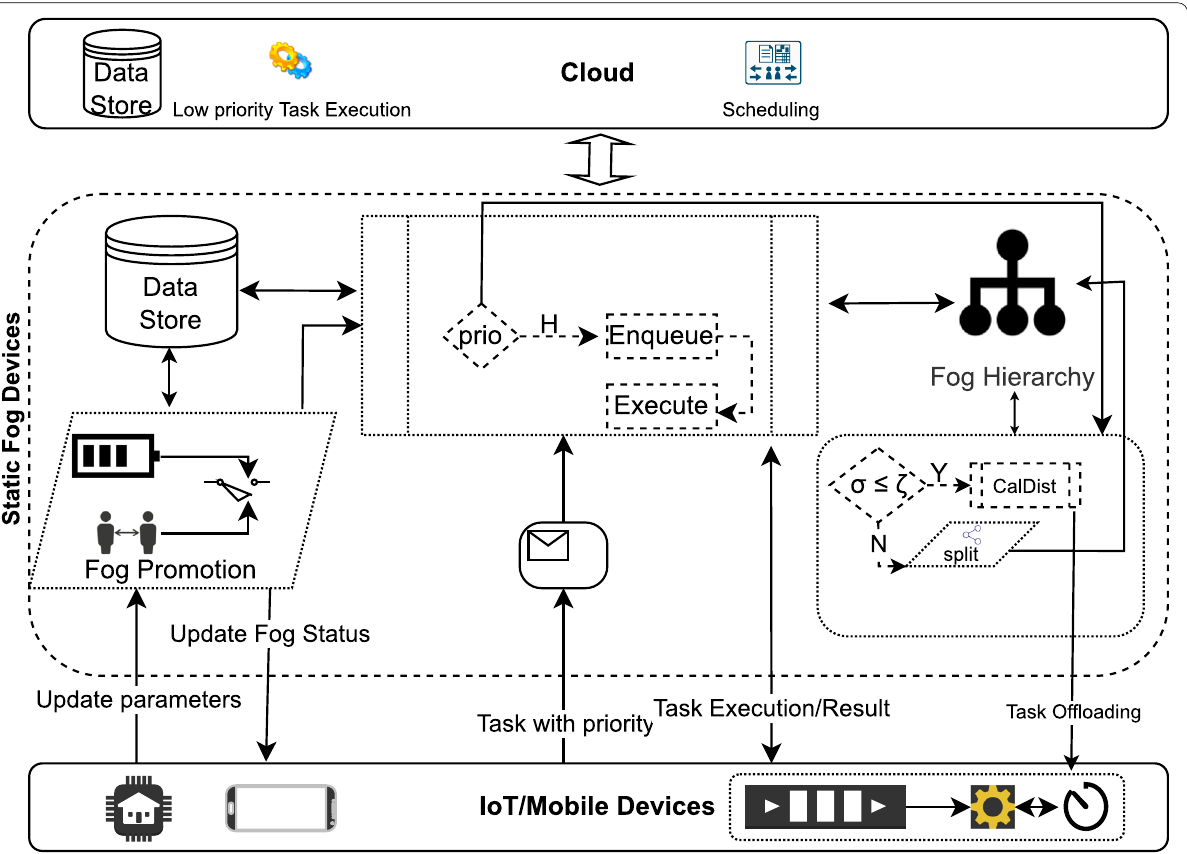
Fig. 2 Architecture of the proposed framework illustrating module